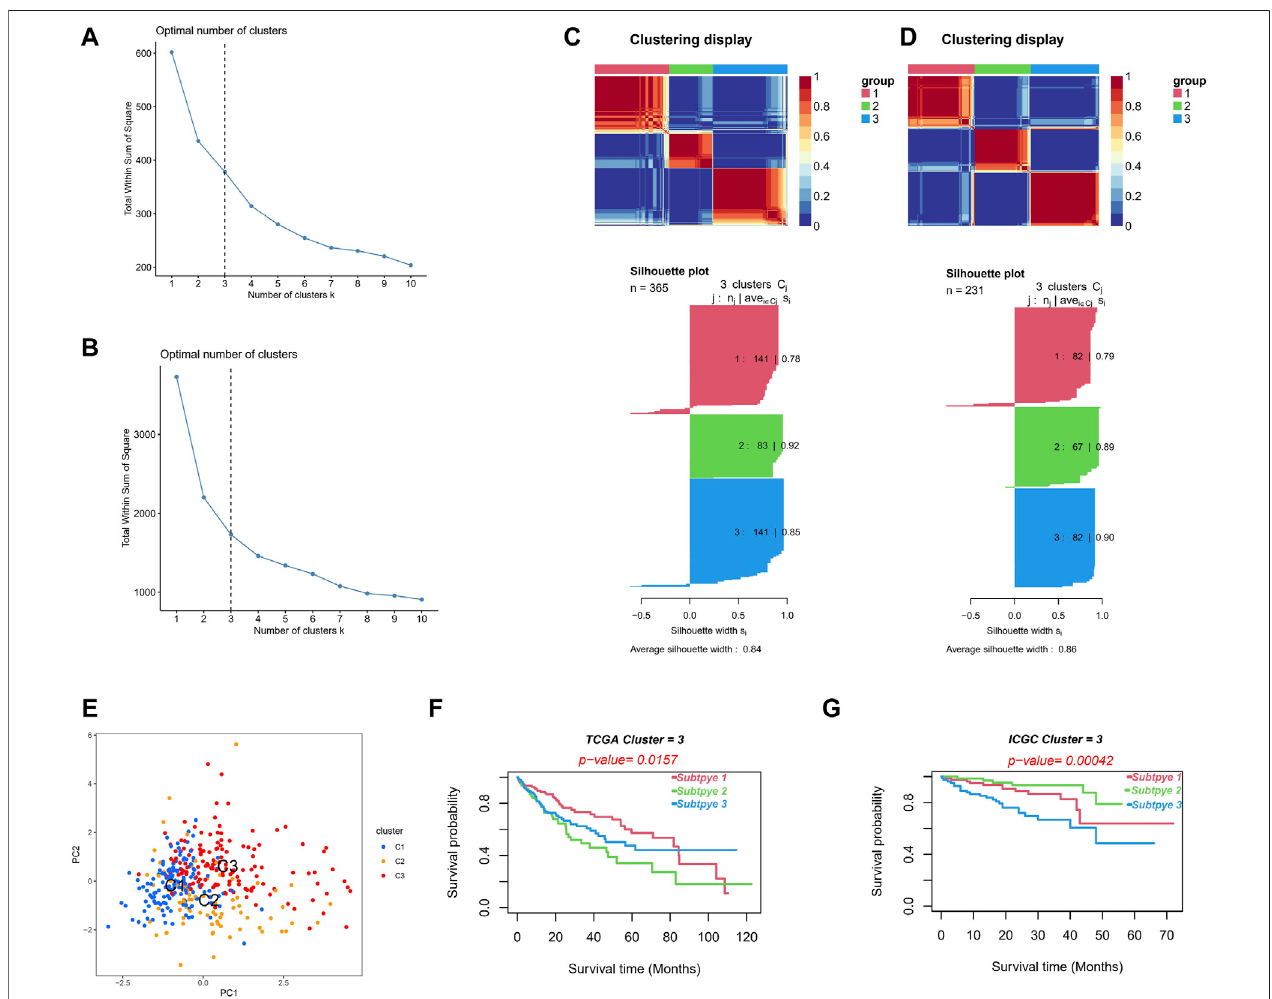
FIGURE 12 | Different molecular subtypes identi fi ed by risk signature. (A,B) Establish the optimal cluster number k value in the TCGA (A) and ICGC (B) cohorts. (C,D) Patients in the TCGA (C) and ICGC (D) cohorts were divided into three clusters using the NMF clustering algorithm. (E) The PCA of clusters. (F,G) Kaplan – Meier survival curves of OS in three